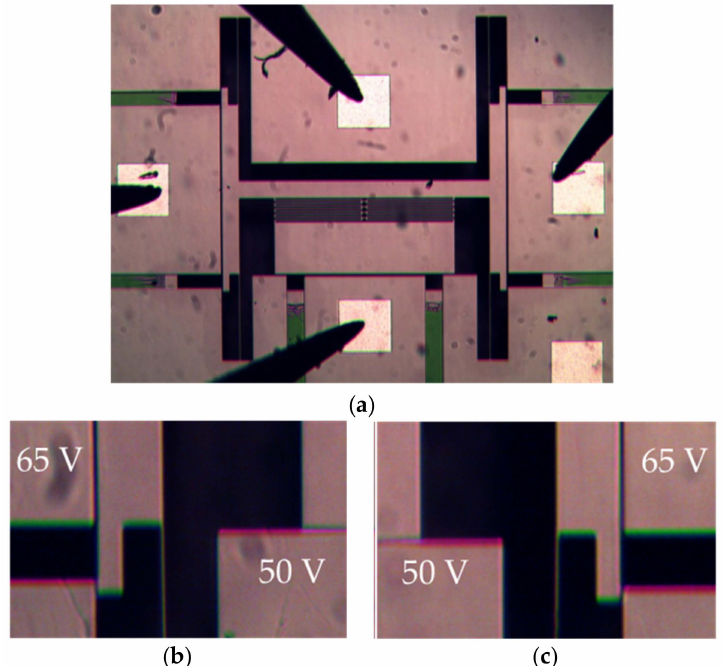
Figure 11. ( a ) Microscopic micrographs of the device at 0 V during actuation tests with probes on MEMS; ( b ) zoomed in image of the left switching actuator at 65 V and gap closing actuator at 50 V; ( c ) zoomed in image of the right switching actuator at 65 V and gap closing actuator at 50